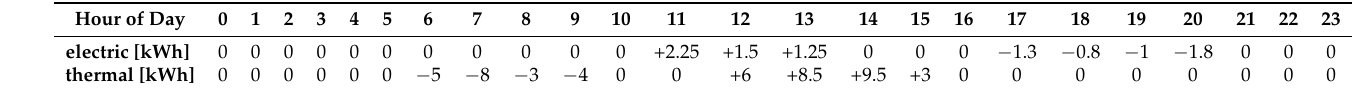
Table 1. An example of an explicit DR message for load adjustment.